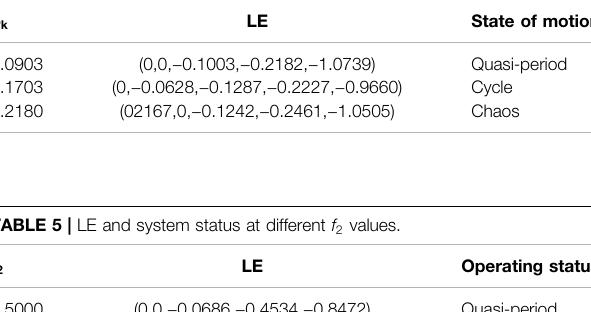
TABLE 2 | LE and system status at different p e values.